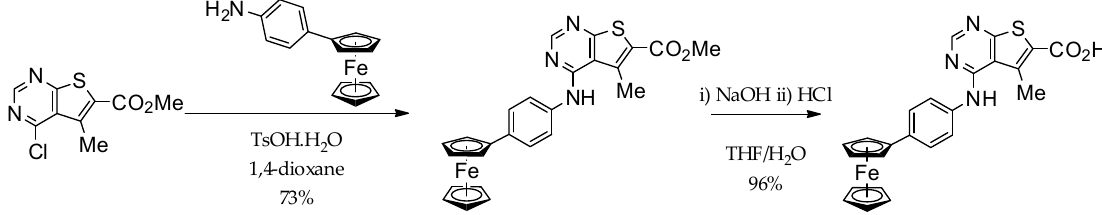
Scheme 1. Synthesis of ferrocene analogue, 3 .